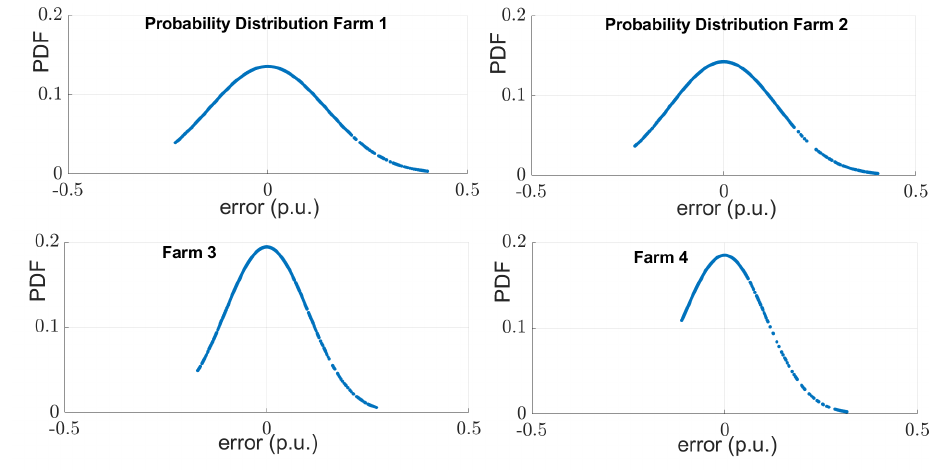
Figure 5. The first hour measured power error